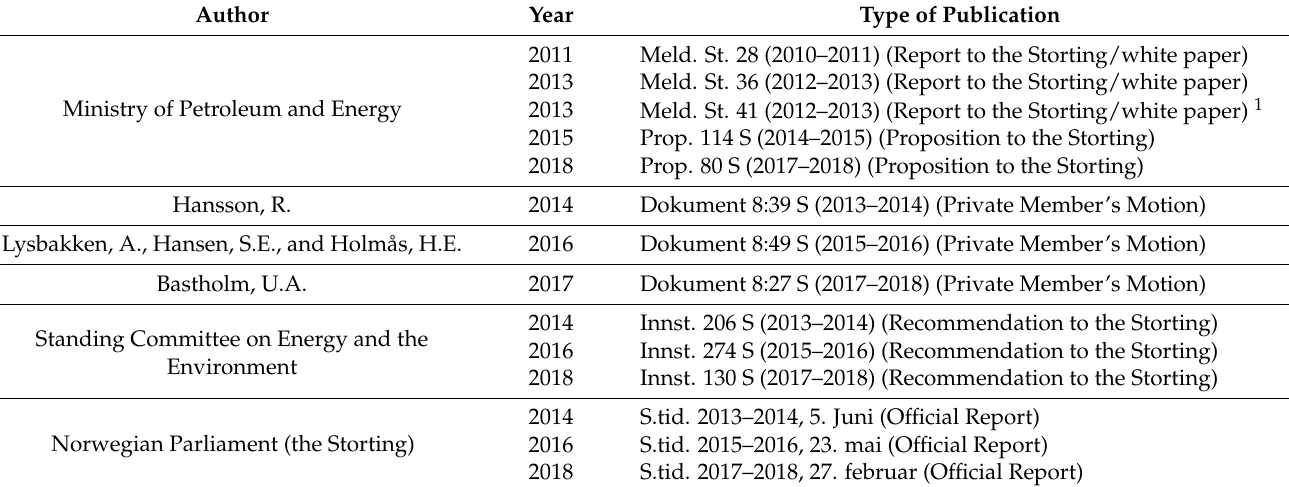
Table 1. Governmental and parliamentary documents chosen for